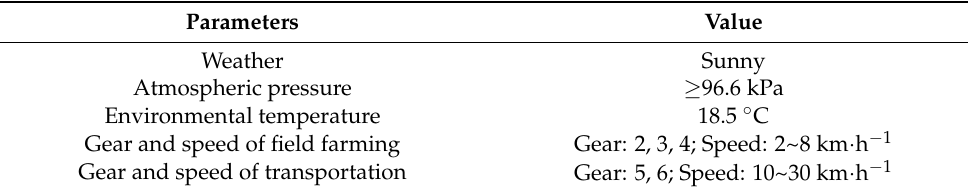
Table 1. Field experiment condition